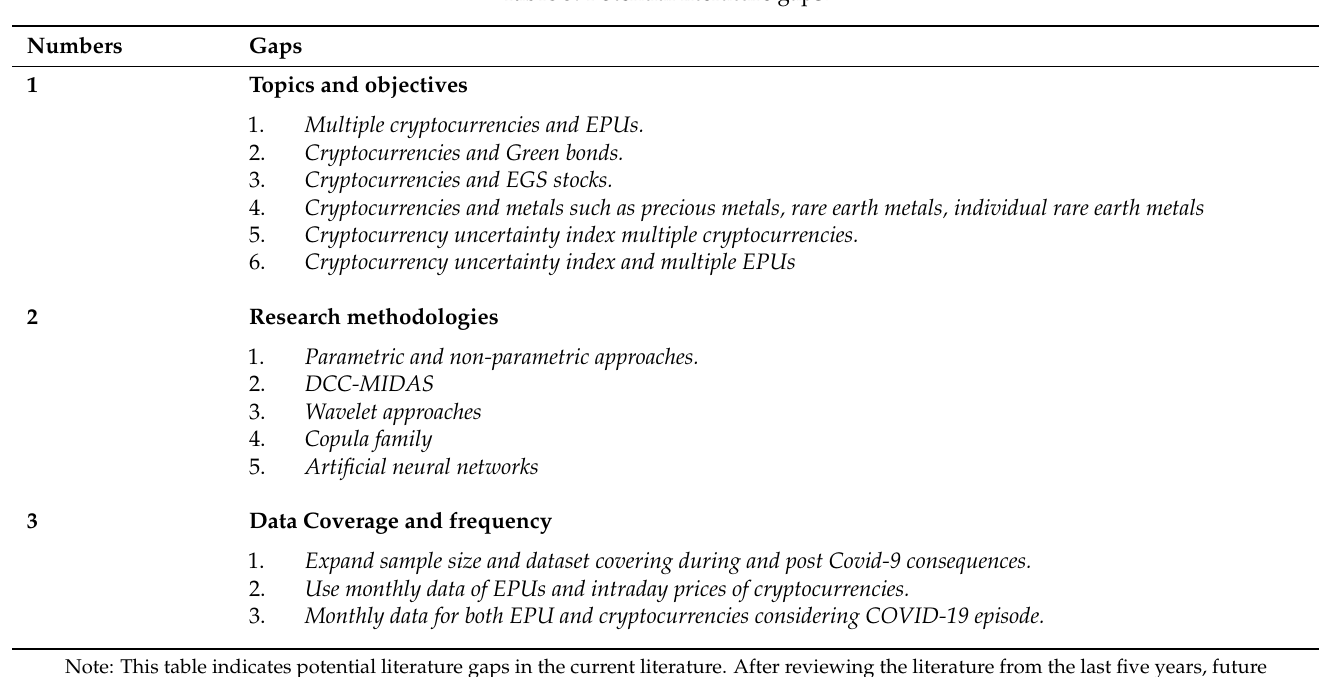
Table 5. Potential literature